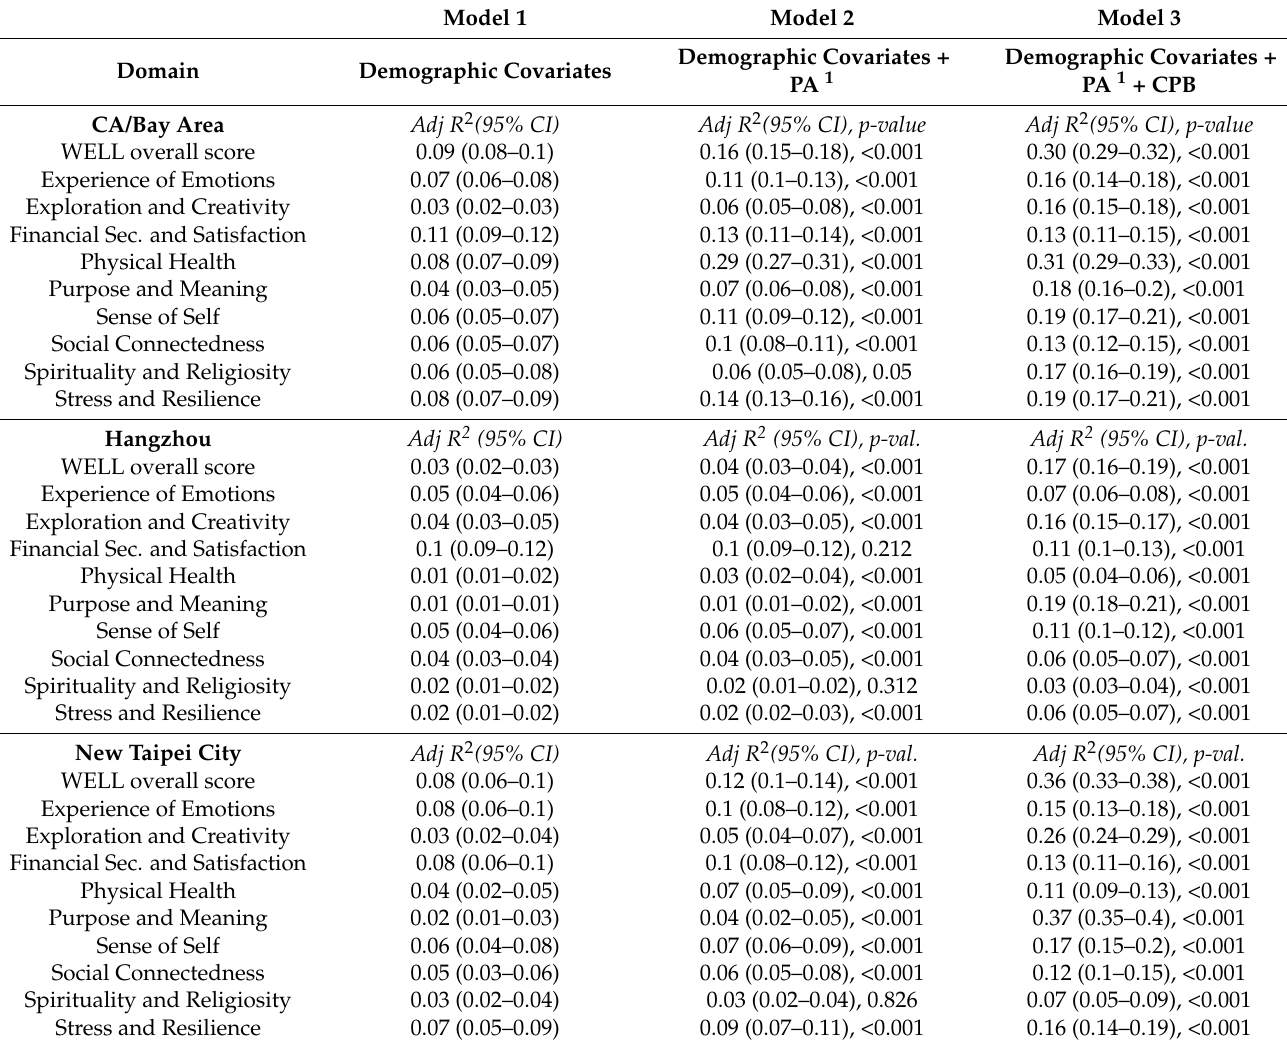
Table 5. Adjusted R 2 Values with Confidence Intervals and Wald Tests of Significance for the Models in Hierarchical